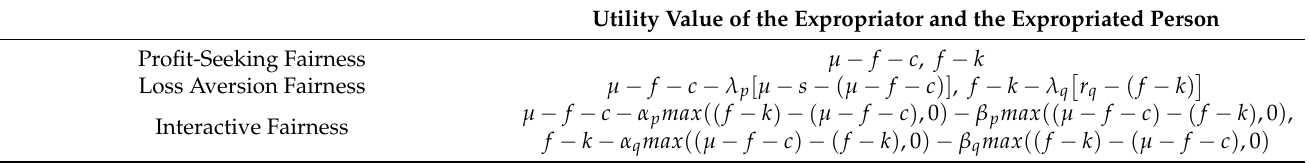
Table 5. Compensation scheme for urban housing expropriation 2 (fair expropriation, boycott). Utility Value of the Expropriator and the Expropriated Person